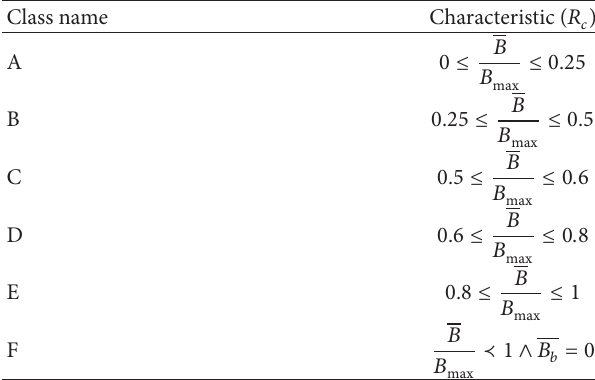
Table 1: Traffic classes by